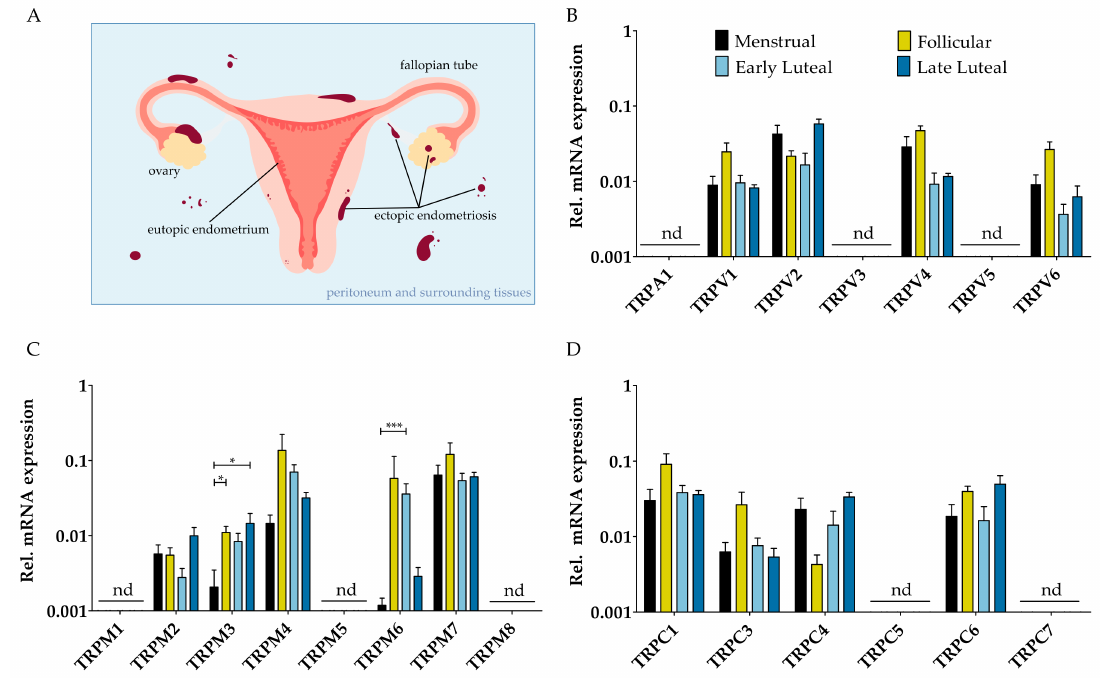
Figure 1. mRNA expression of TRP channels in eutopic endometrium . ( A ) Retrograde